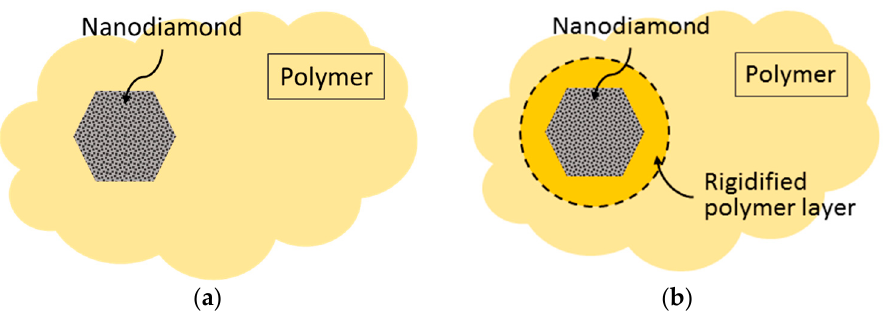
Figure 7. A schematic morphology of polymer membrane with dispersed nanoparticles: ( a ) ideal structure; ( b ) with rigidified polymer layer.